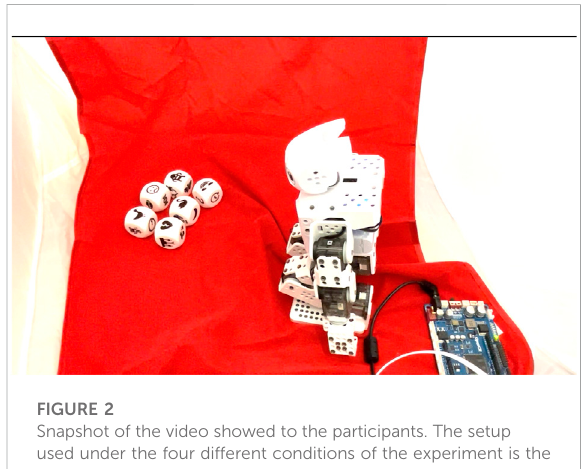
FIGURE 2 Snapshot of the video showed to the participants. The setup used under the four different conditions of the experiment is the same (cubes, robot, and microcontroller in the